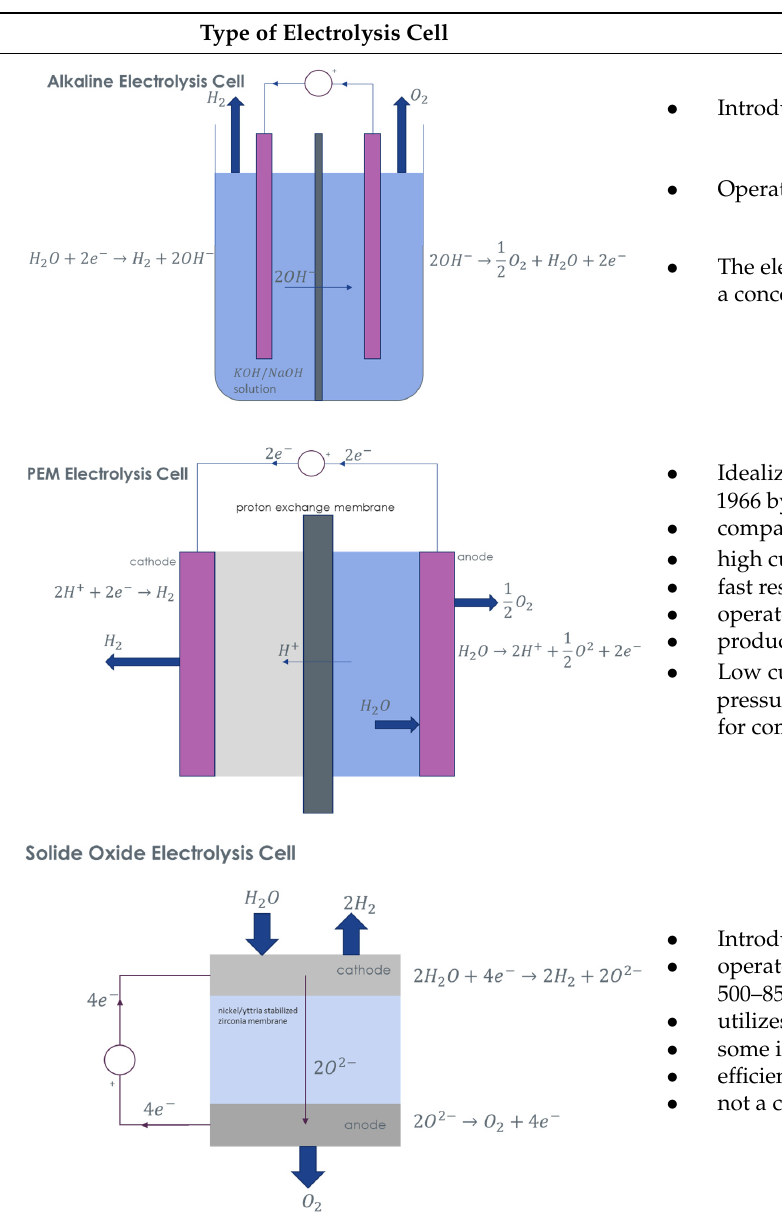
Table 4. Comparison between electrolyzers technologies [76].